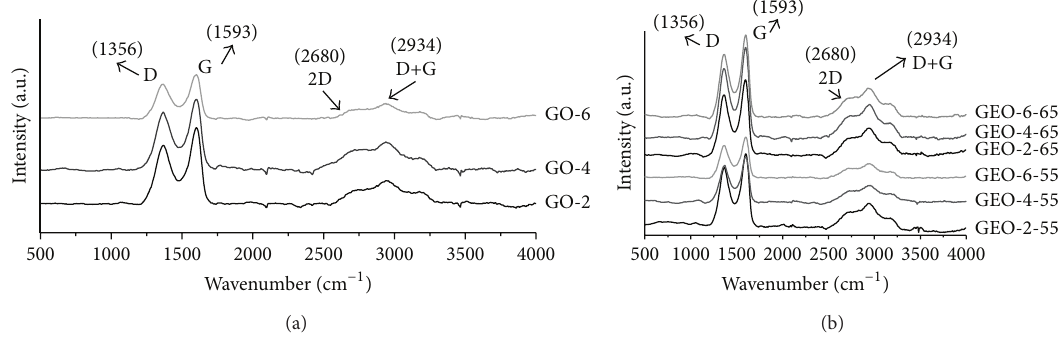
Figure 2: Raman spectra of (a) GO-2, GO-4, and GO-6 and (b) GEO-2-55, GEO-4-55, GEO-6-55, GEO-2-65, GEO-4-65, and GEO-6-65.